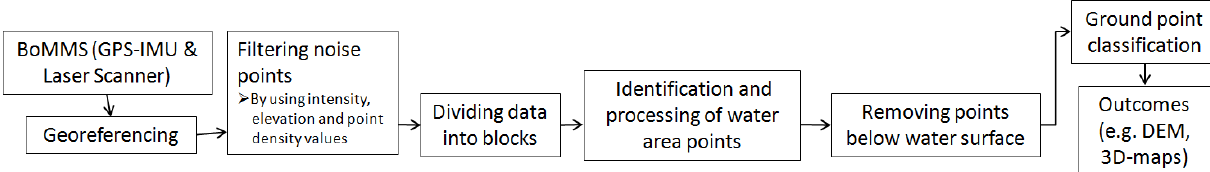
Figure 2. The processing chain for BoMMS point cloud